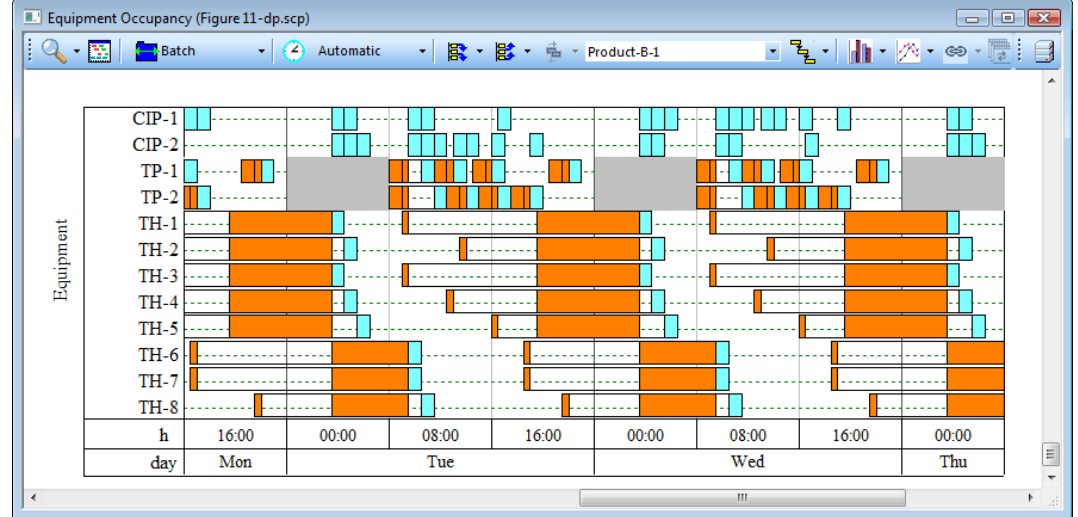
Figure 10. Scheduling of buffer preparation and holding